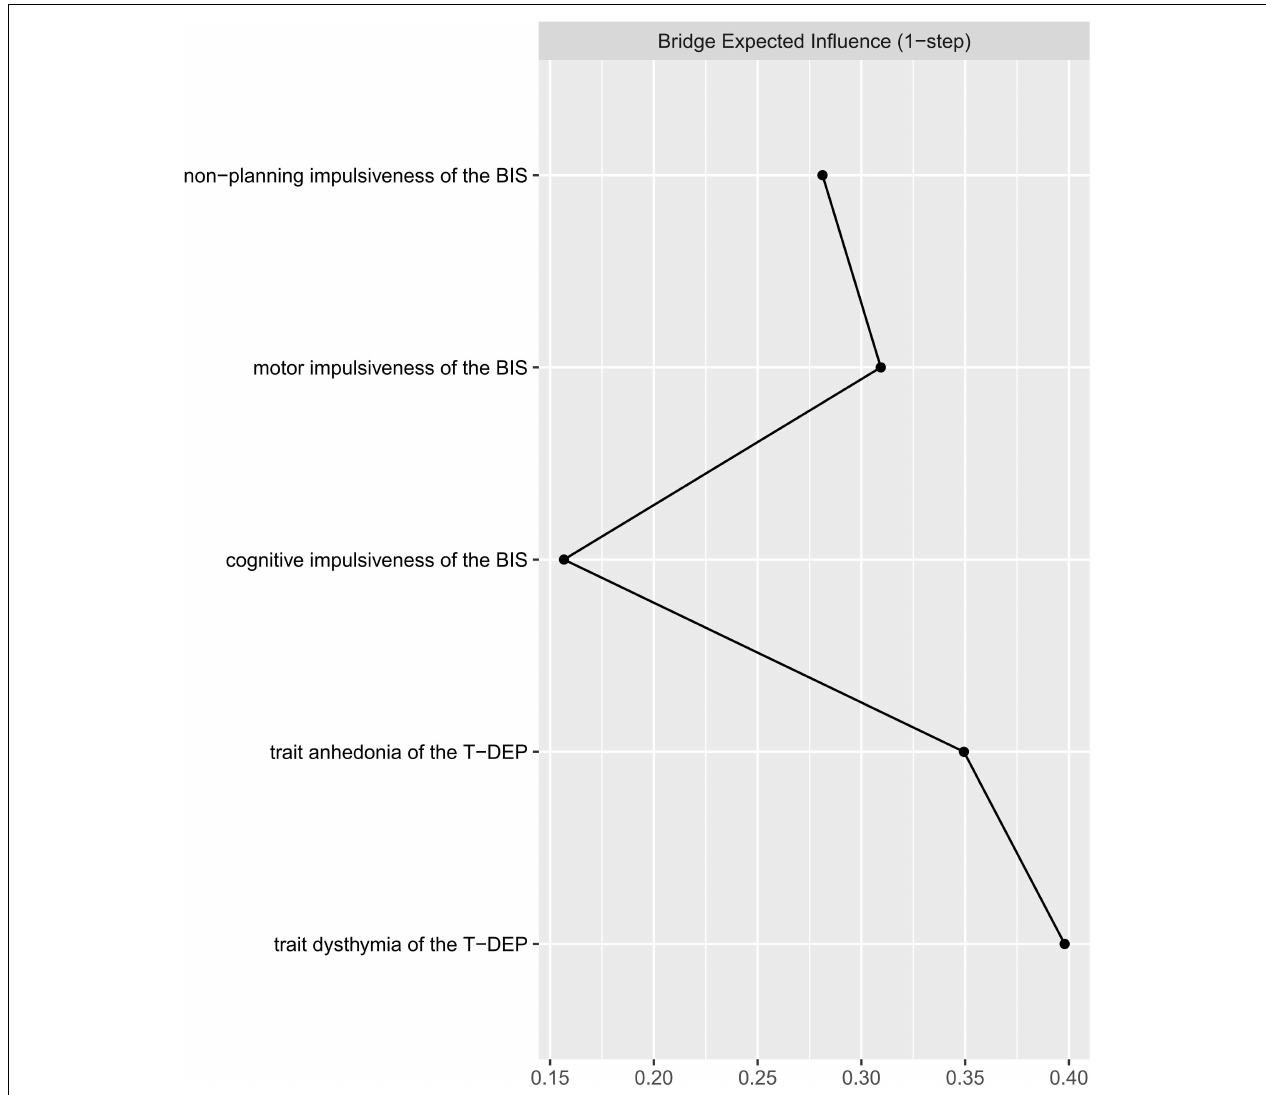
FIGURE 4 | Centrality plot of the bridge expected influence between trait depression and